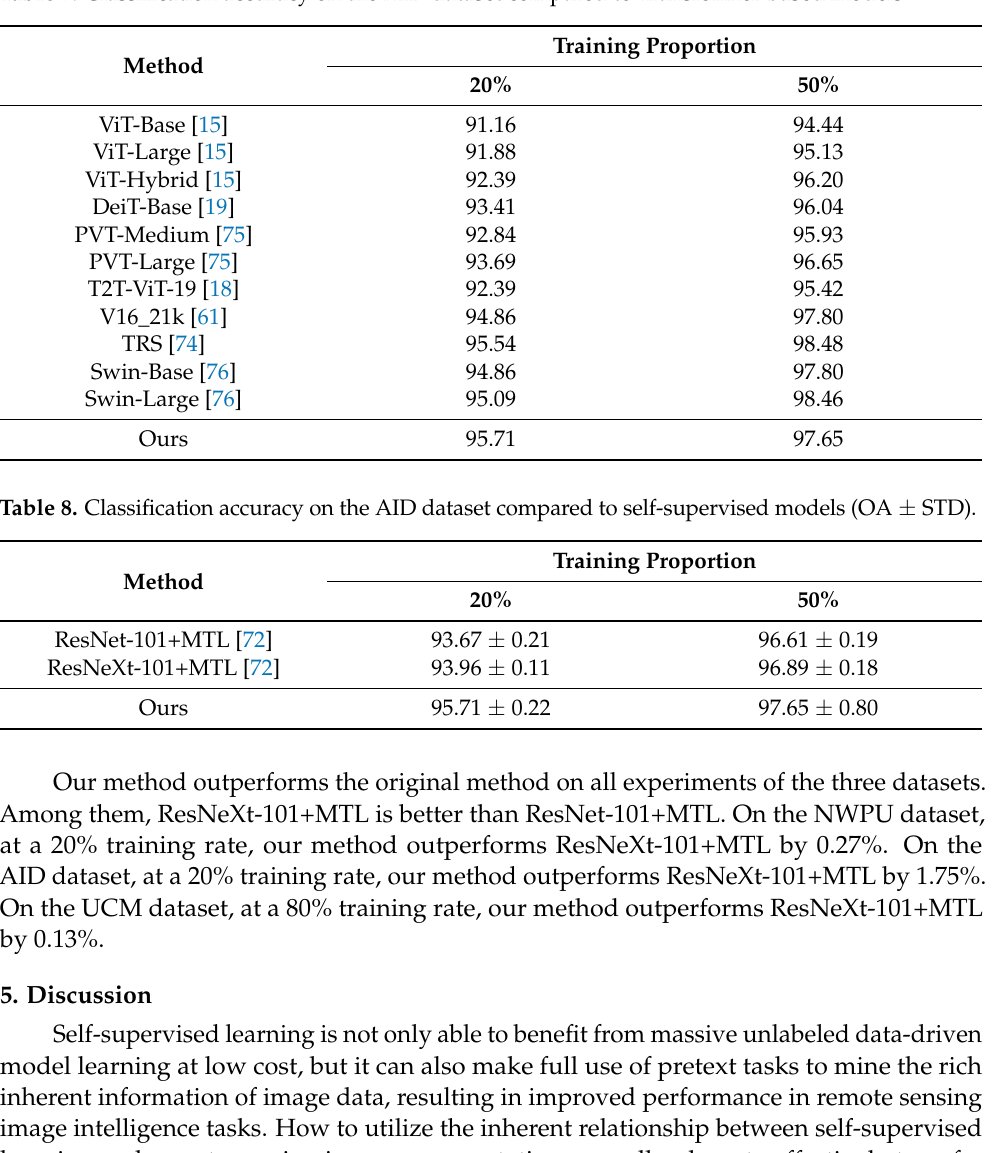
Table 7. Classification accuracy on the AID dataset compared to Transformer-based models.